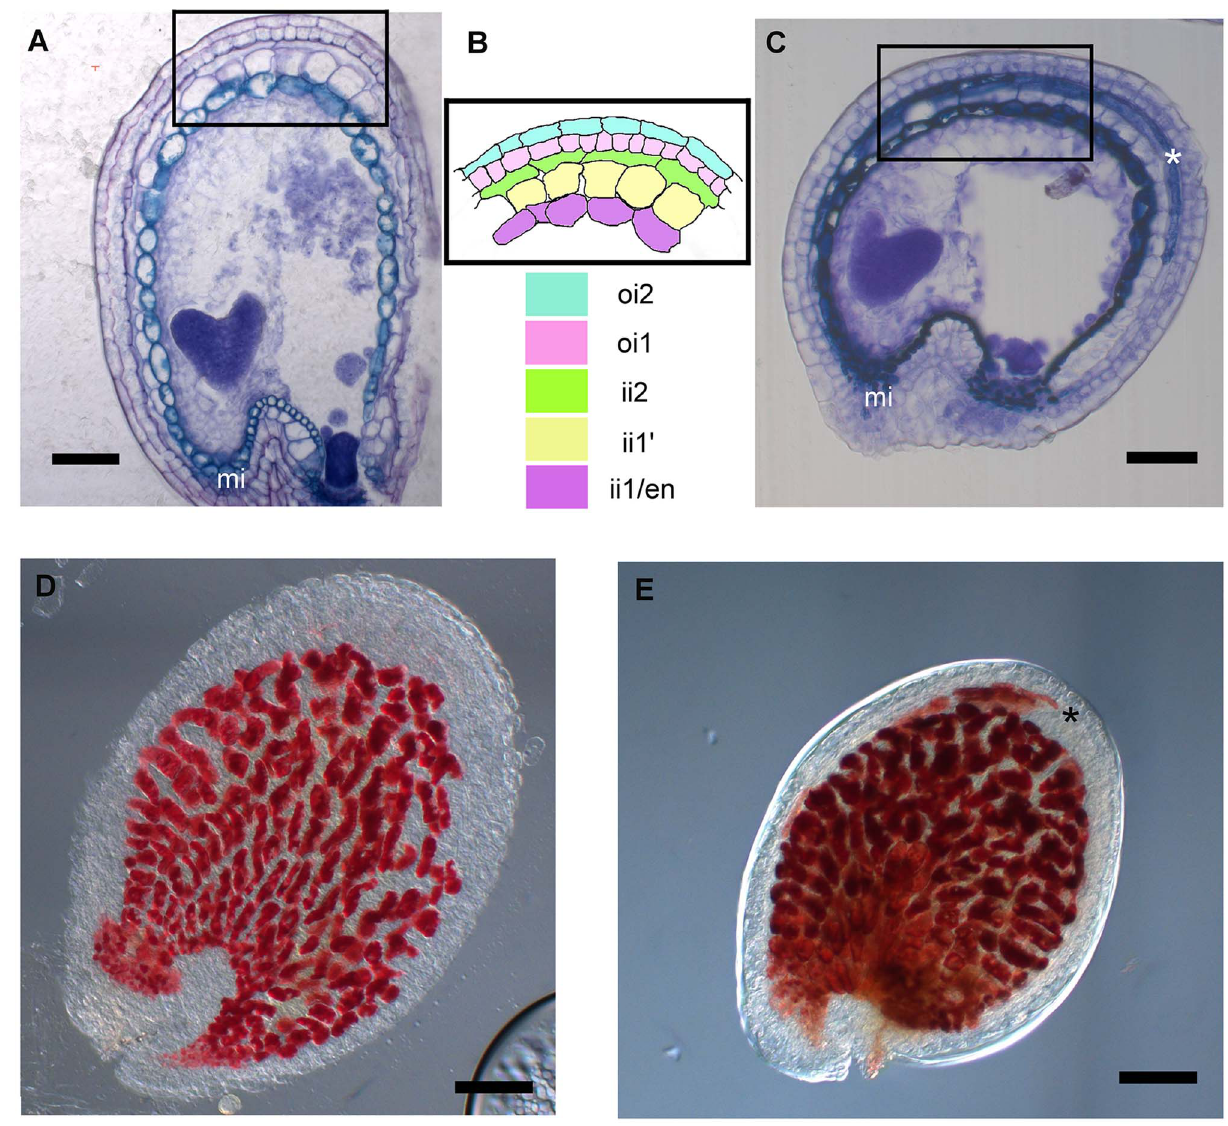
Fig. 2. stk mutant seeds present defects in seed coat PA accumulation. ( A ) Sections of wild-type seeds stained with the toluidine blue O revealed the presence of phenolic compounds in the endothelium (ii1). ( B ) Scheme of Arabidopsis seed coat anatomy. ( C ) In the stk mutant phenolic compounds are accumulated in the endothelium (ii1) and also in the second layer of the inner integument (ii2, asterisk). ( D ) Whole-mount vanillin staining confirmed the presence of PAs in the wild-type and ( E ) in the stk mutant endothelium. In the stk mutant PAs are also accumulated outside the endothelium in the second layer of the inner integument (asterisk). mi, micropyle; en, endothelium. Scale bars=30 m m ( A–E ).